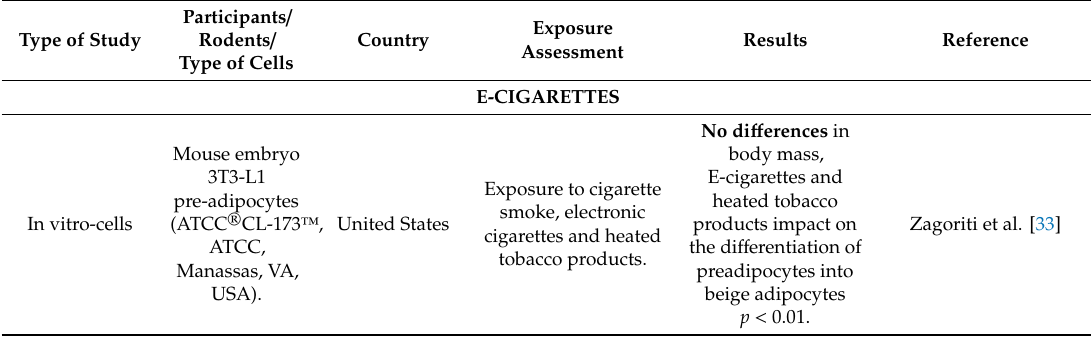
Table 5. The impact of electronic cigarettes use and tobacco smoke exposure on abdominal